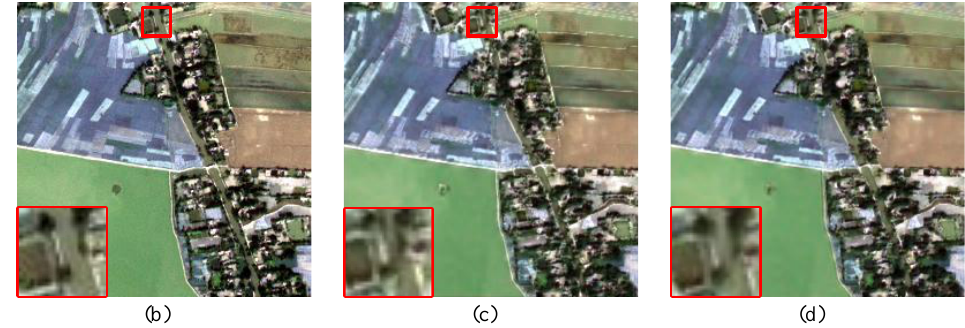
Figure 8. The comparison of 2D and 3D convolution results on the QuickBird dataset. ( a ) PAN. ( b ) The ground truth. ( c ) The 2D convolutional method. ( d ) The 3D convolutional method. Table 6. The comparison of 2D and 3D convolution results on QuickBird.